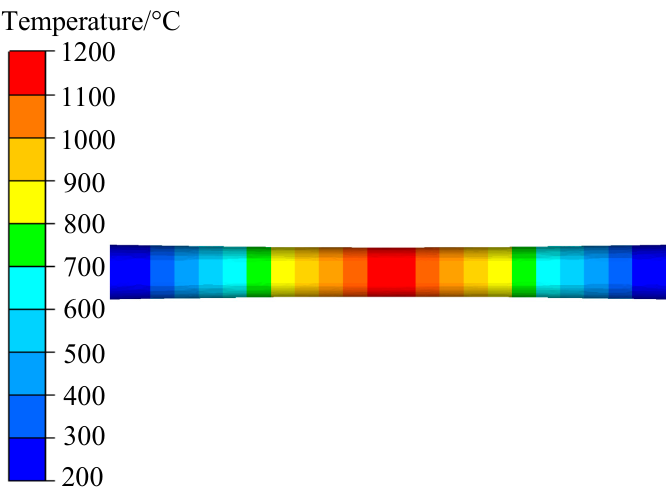
Figure 9. Cr5 alloy steel tensile simulation test modelling schematic diagram.